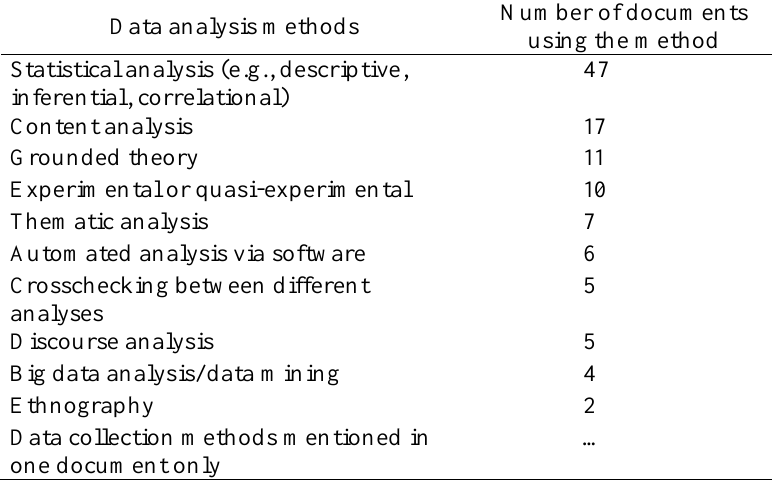
Table 6 Data Analysis Methods and Their